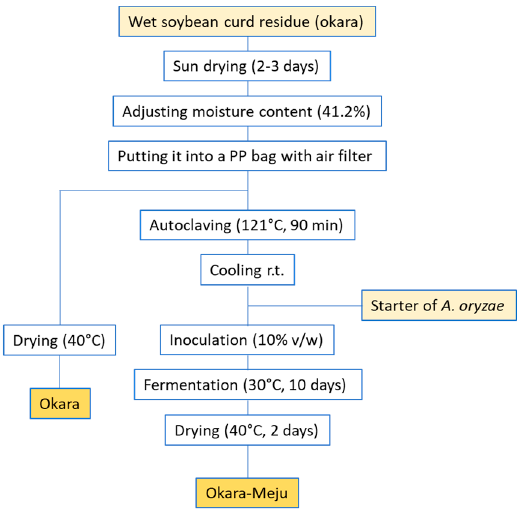
Figure 7. Procedure for the preparation of fermented SCR (okara-meju).